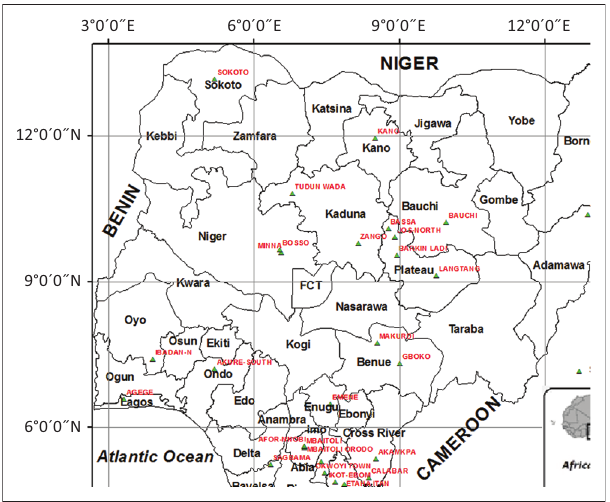
FIGURE 3: Map of Nigeria describing the GPS location of sampling indicated in red ink and lineages